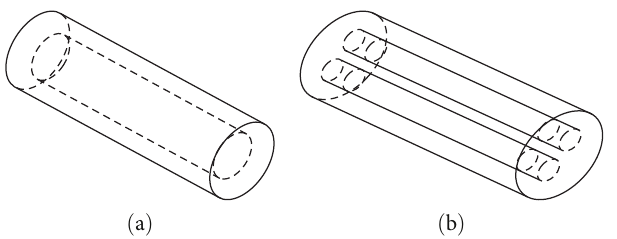
F IGURE 2: Schematic diagram of the chamber structure of the com- ponents: (a) chamber structure of the expansion part; (b) chamber structure of the deformation part.